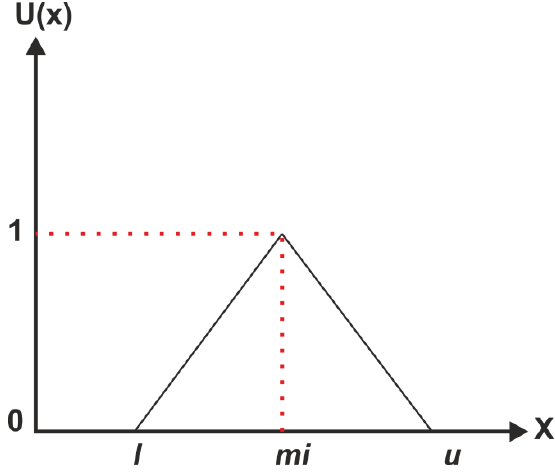
Figure 3. Triangular fuzzy numbers.